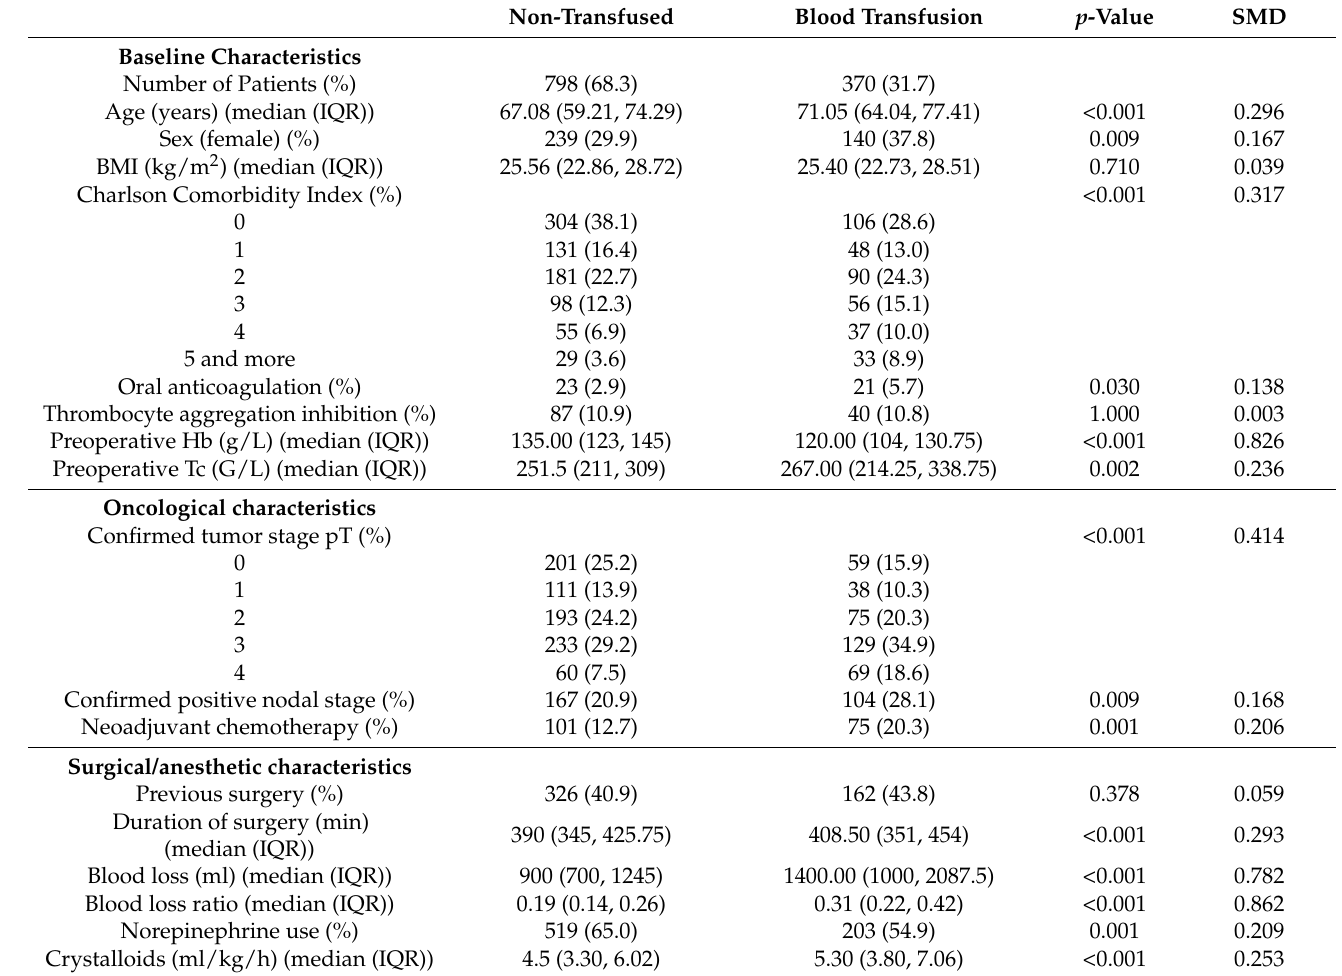
Table 1. Baseline, oncological, and surgical/anesthetic characteristics.